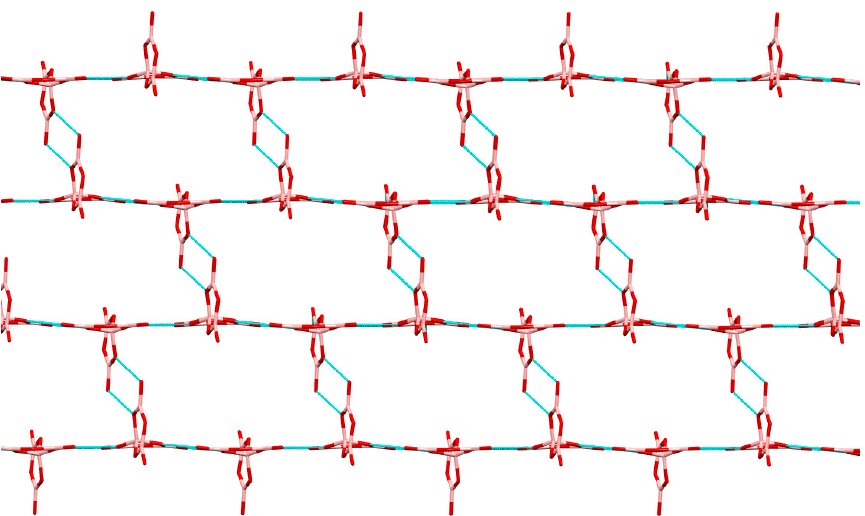
Figure 2. Giant lattice arising from pentaborate(1-)-pentaborate(1-) interactions in 3 , viewed along the b axis. Cations have been omitted for clarity, but are situated within ′ cavities ′ . Within this ′ plane ′ each pentaborate(1-) in shown H-bonding to 3 other pentaborate(1-) anions by R 2 2 (8) interactions. A fourth C(8) interaction (not shown) links these planes.